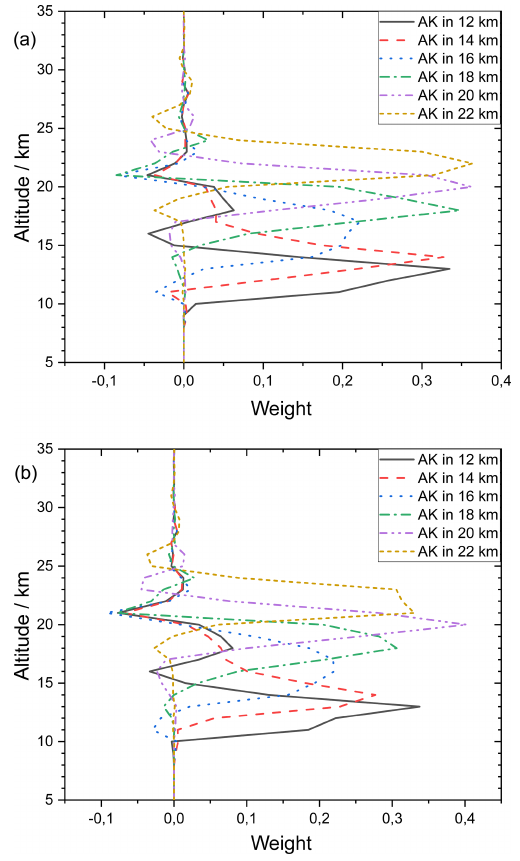
Figure 4. Averaging kernels of a MIPAS measurements near Nairobi on 3 August (a) and 23 September 2010 (b) . The MIPAS altitude resolution is altitude dependent and varies between 2.7 and 4.5km below 22km altitude, with typical values of around 3.0km. To avoid overly busy plots, only every other averaging kernel is shown.